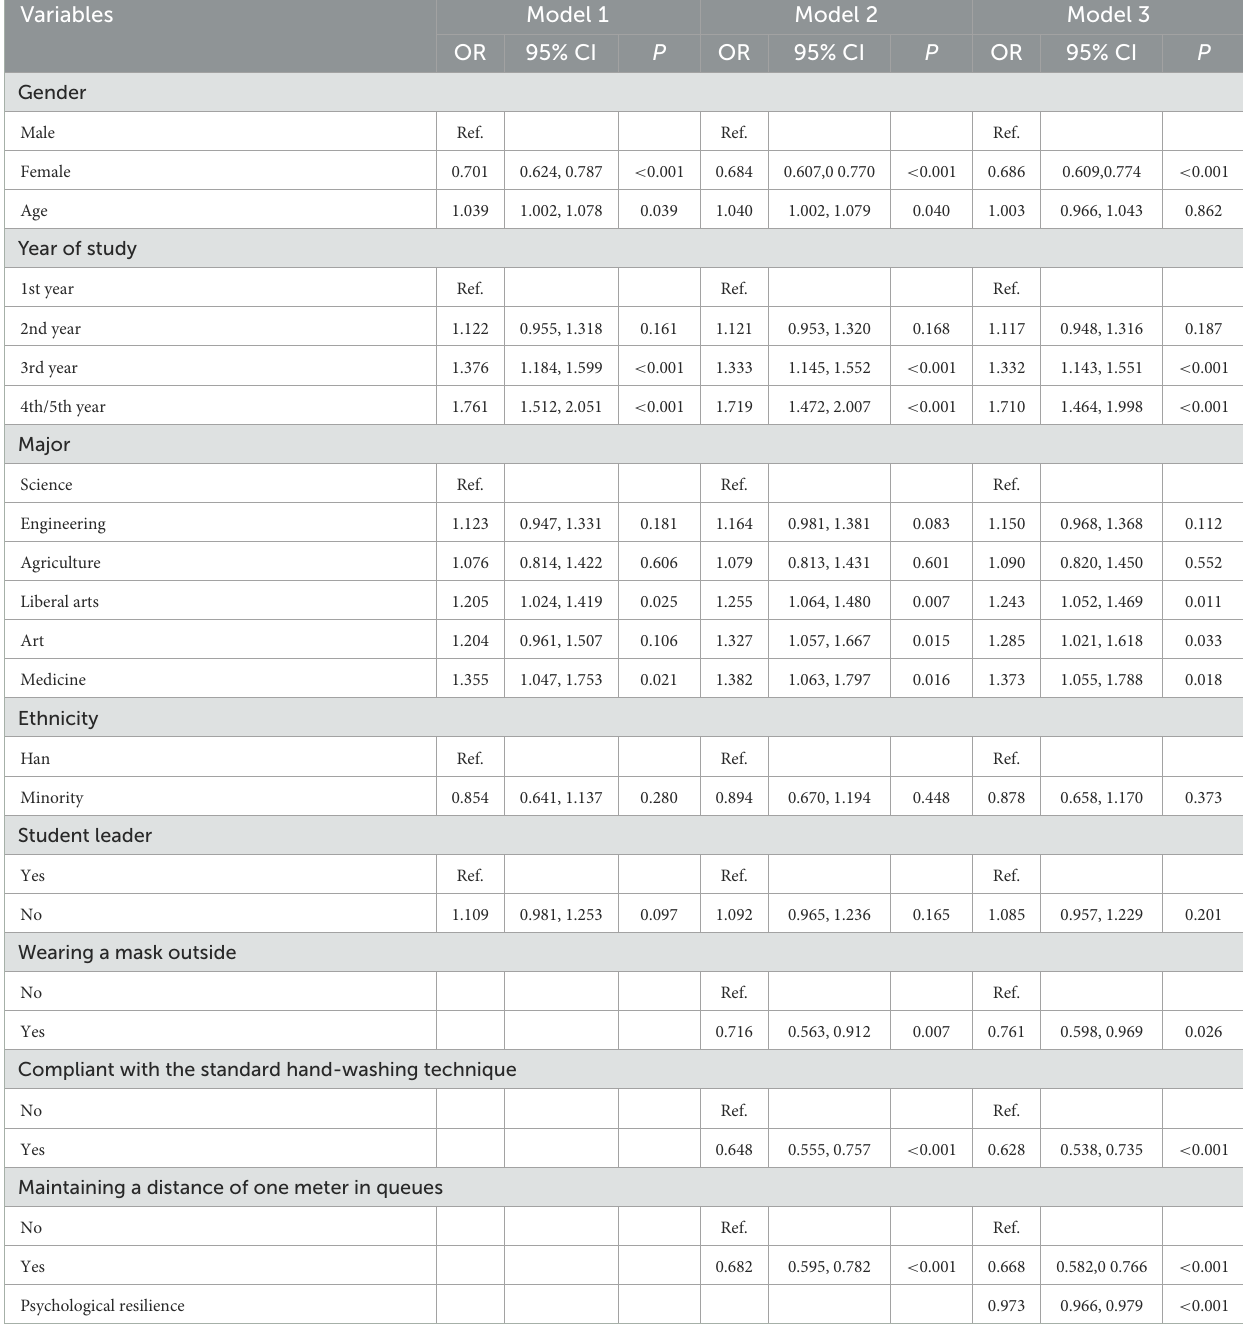
TABLE 3 Longitudinal associations of epidemic preventive behaviors and psychological resilience with depression based on